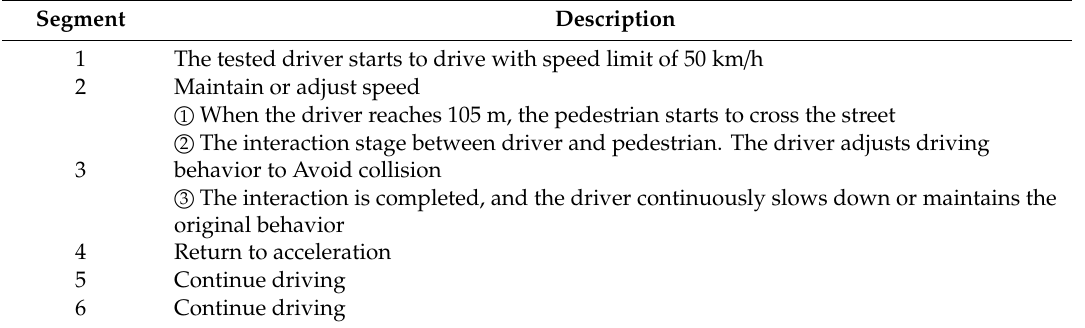
Table 4. Description of each segment in risk scenarios.